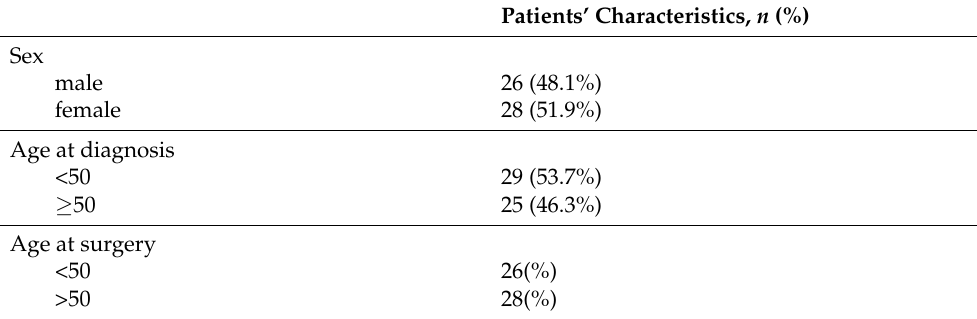
Table 1. Patients’